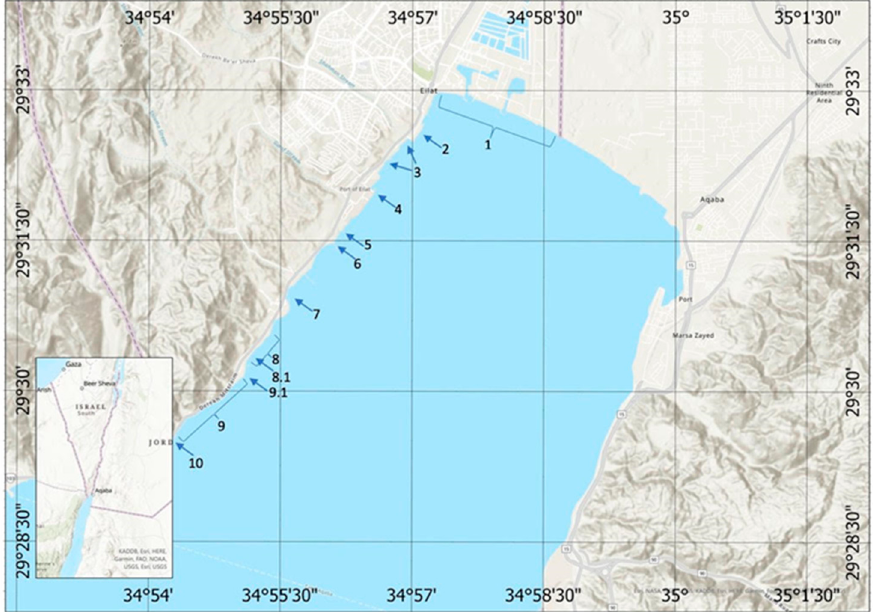
Figure 1. The Gulf of Eilat, located at the northern tip of the Red Sea (see insert). The numbers indicate subregions discussed in the text: 1. North Shores, 2. Navi, 3. Hachashmal and Hadekel Beach, 4. Port of Eilat, 5. Dolphin Reef, 6. Pier 1 (Ecological Beach), 7. South Marina, 8. The Coral Beach reserve (Closed Reserve), 8.1. The Japanese Gardens, 9. The South Shore reserve (Open Reserve) and Sharem Al’ Sheikh Rd., 9.1. The Migdalor Beach, 10. International border.